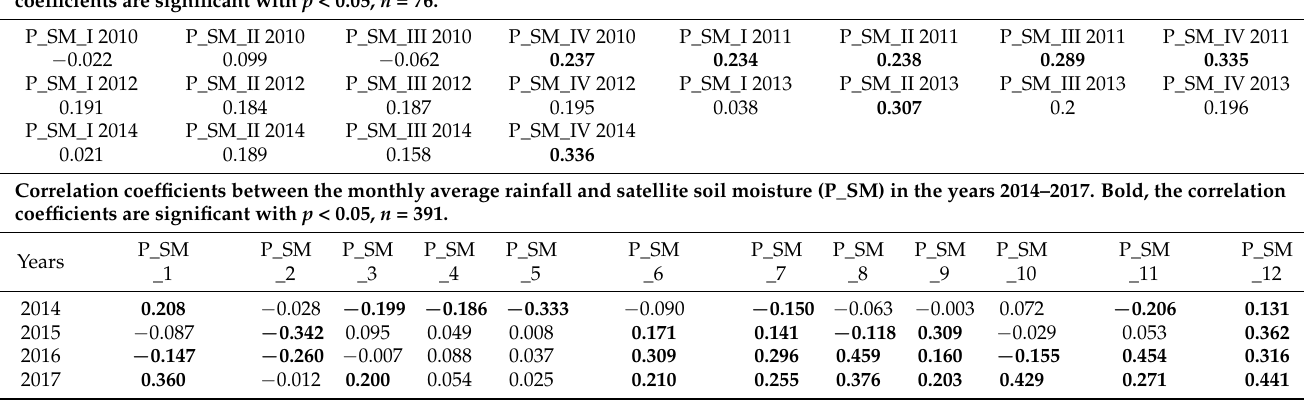
Table 2. Linear correlation coefficients between the quarterly and the monthly average rainfall and satellite soil moisture for Poland and neighbouring